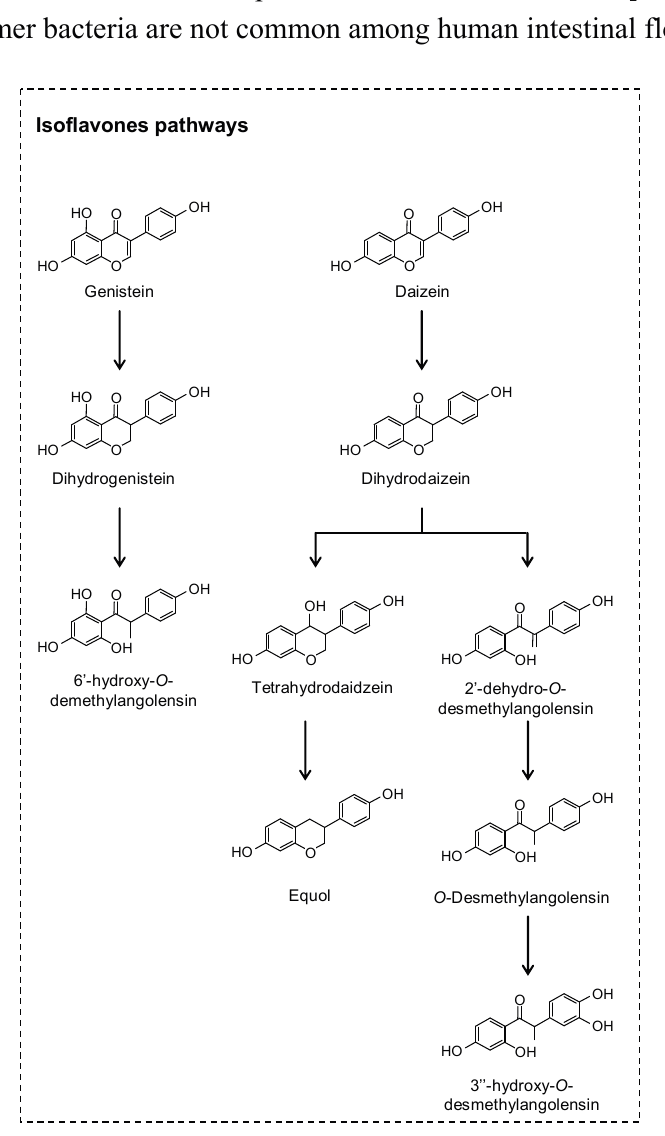
Figure 4. Proposed colonic pathways of